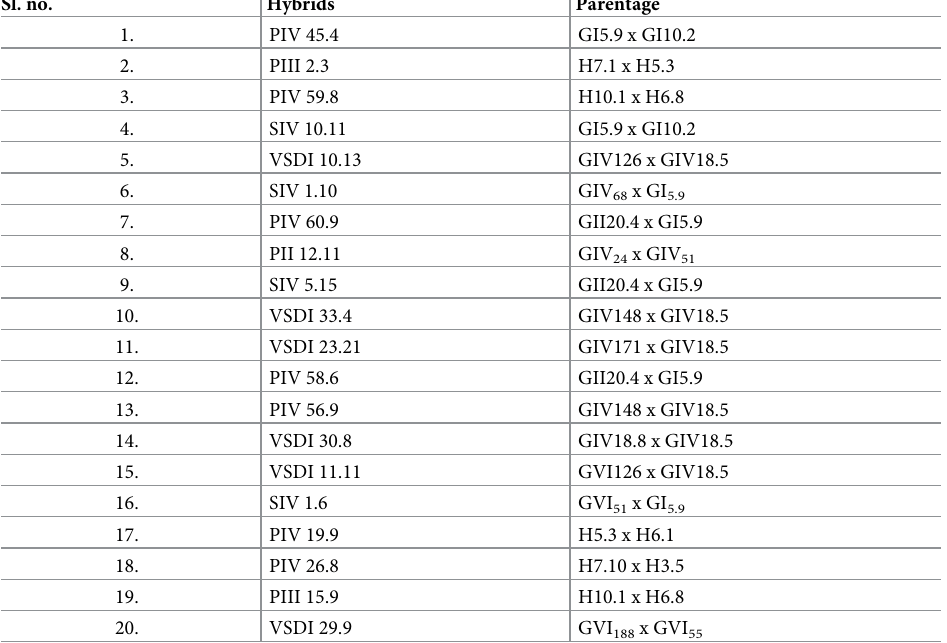
Table 1. List of hybrids selected for tea mosquito bug screening. Sl.